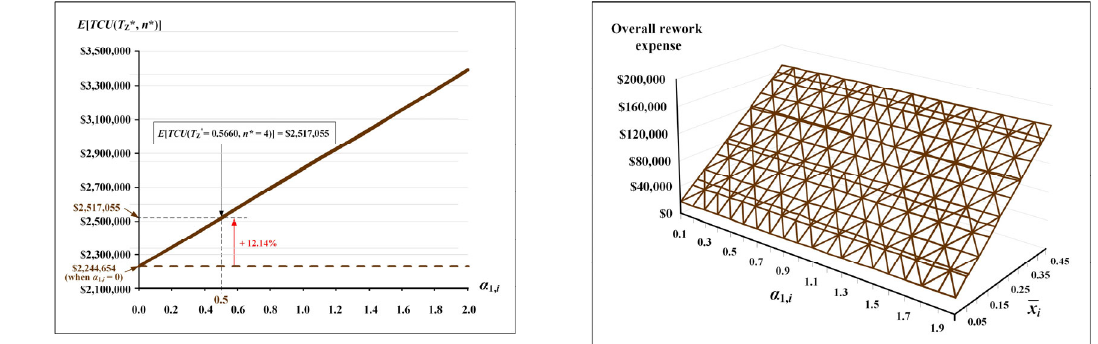
Fig. 10. E [ TCU ( T Z *, n *)]’s performance concerning α 1, i Fig. 11. The collective impact of mean faulty rate and α 1, i on overtime rework